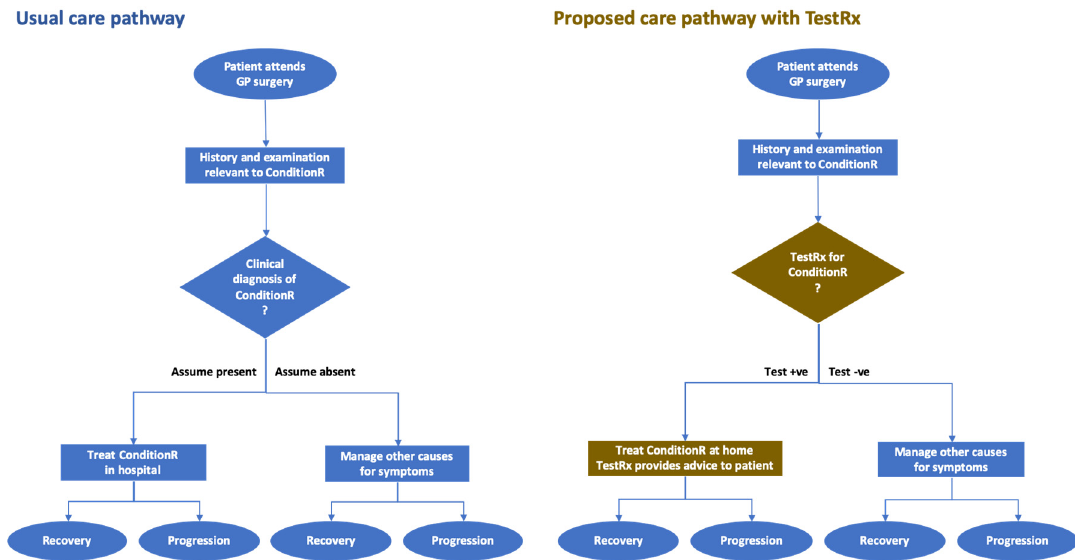
Figure 3. Care pathways for managing ConditionR in current practice and in proposed new practice with the NewTestRx POCT. with the NewTestRx